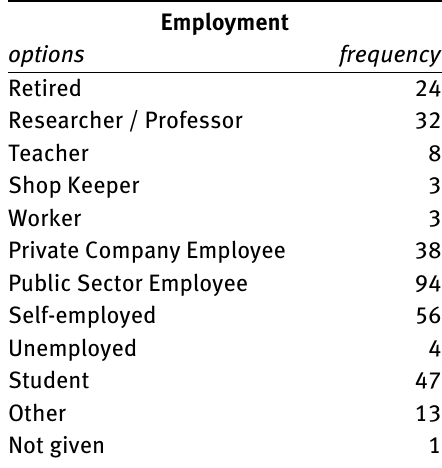
Table 4: Frequency distribution of subjects’ employment data Employment